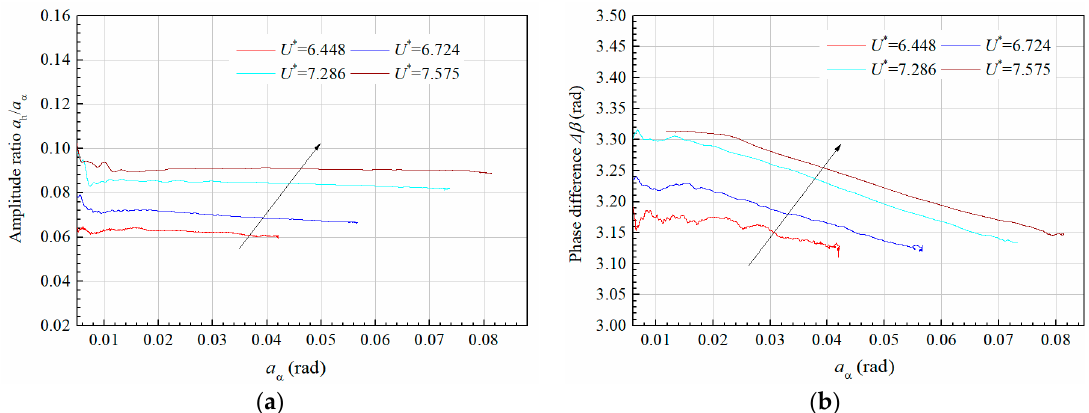
Figure 10. Influence of vibration amplitude on torsional mode (Case B2). ( a ) Mode modulus; ( b ) phase difference.